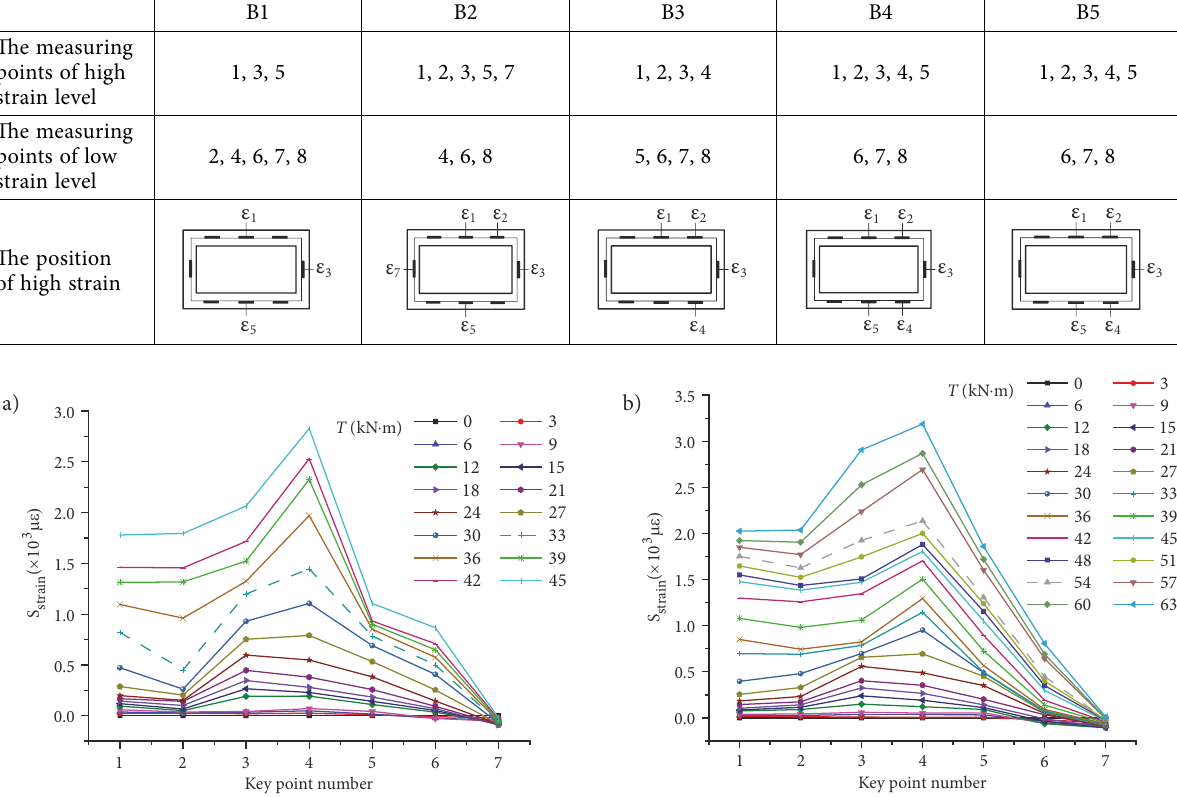
Figure 10. The strain distribution of longitudinal reinforcements for: a – B1; b –